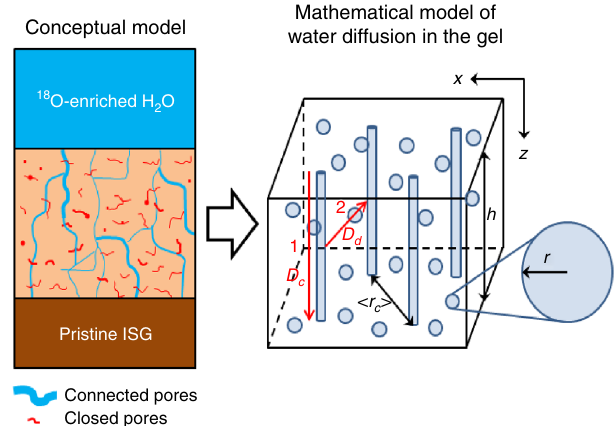
Fig. 3 A model for water diffusion in passivating gels. Conceptual model for interpreting water diffusion in passivating gel (left) and the corresponding mathematical model used to determine the water diffusion coef fi cients (right). The gel is assumed to contain spherical pores with mean pore radius, r , and a fraction of the pores are connected in aggregates that run from the solution/gel interface to the gel/pristine glass interface and are thus treated as cylinders with mean separation distance, < r c >. Exchange modes 1 and 2 with diffusion coef fi cients D c and D d , respectively,